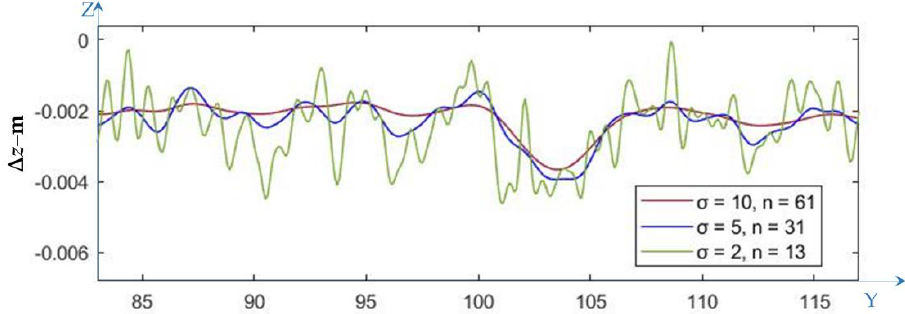
Figure 21. Profile of smoothing results with different Gaussian parameters (m).